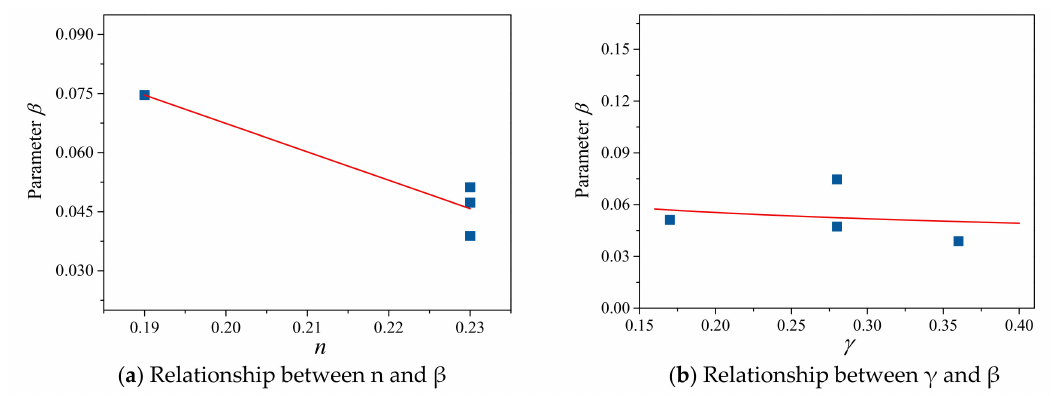
Figure 15. Relationship curves of torsional damage parameter β